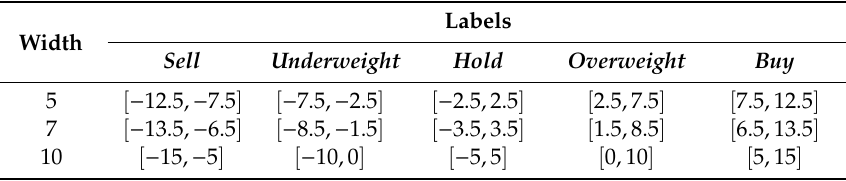
Table 2. The term-set with associated intervals.